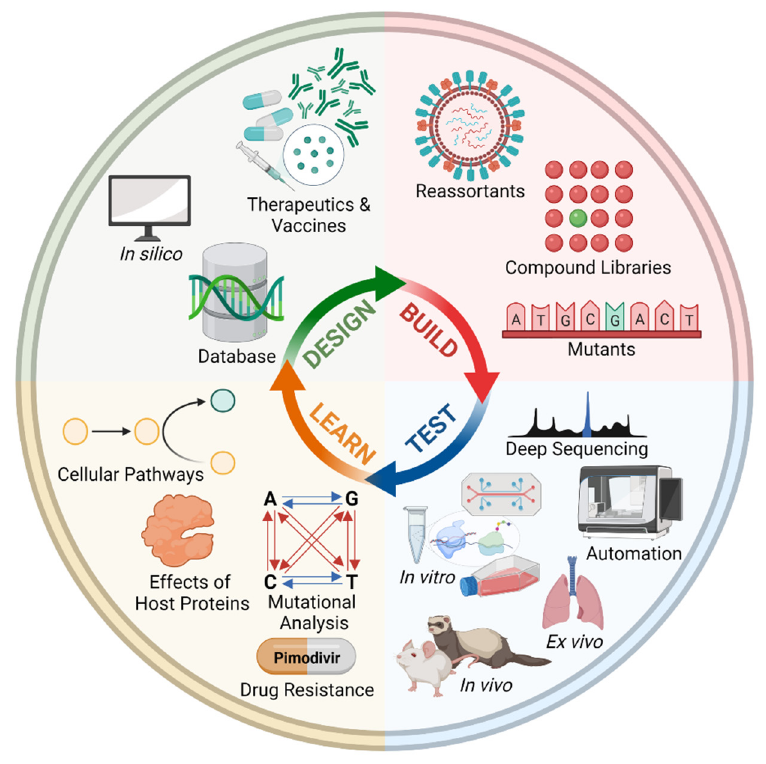
Figure 5. Framework of a design-build-test-learn (DBTL) for H5N8 to complement surveillance. Created with BioRender.com.